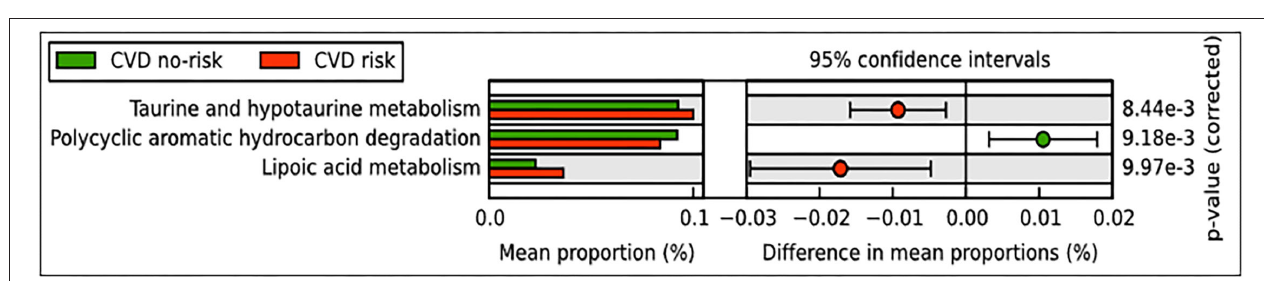
FIGURE 4 | Gut microbial markers and their validation in the CVD risk group. (A) Gut microbial markers were measured by LEfSe analytical tool with an LDA cut-off value of > 2.0 in both the CVD no-risk and CVD risk groups. (B,C) Gut microbial markers from LEfSe analysis were validated using the SIAMCAT tool, which displayed the cross-validation error as a receiver operating characteristic (ROC) curve with the 95% confidence interval shaded in gray. The area under the ROC (AUROC = 0.733) is given below the curve. The x -axis and y -axis represent false-positive and true-positive rates, respectively, for the tested markers. An AUROC value of more than 0.7 is considered fairly good in terms of the test’s discriminative ability. CVD no-risk, N = 36; CVD risk, N = 10. “g_UC”: unclassified bacteria at the genus level.